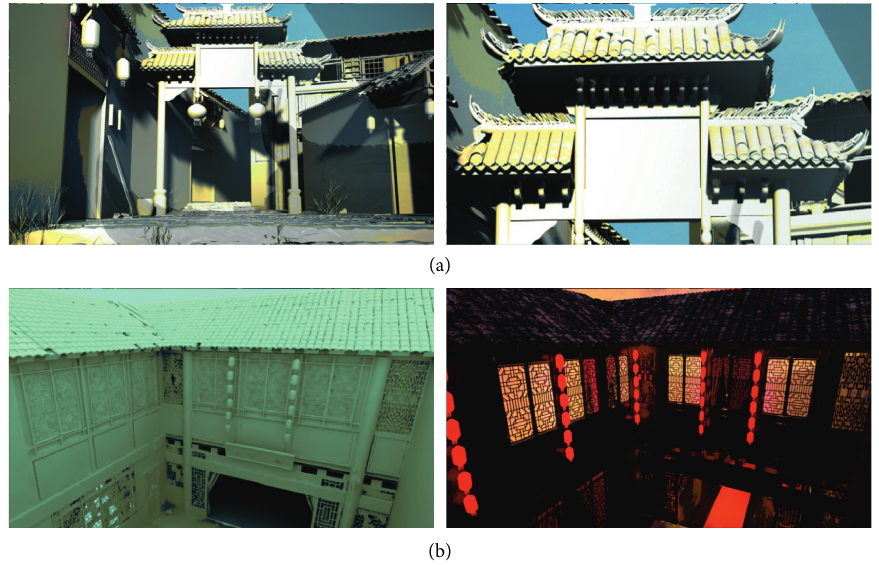
Figure 9: (a) Eaves tile modelling and (b) retrospective window